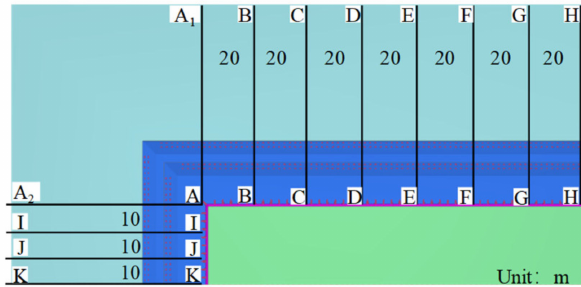
Figure 12. The positions of section.